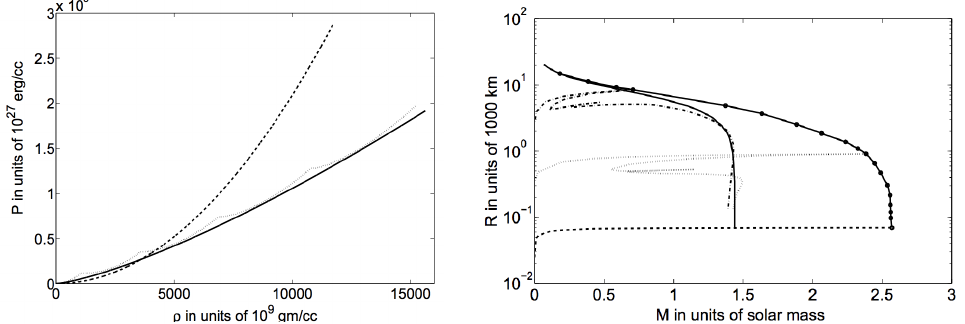
Figure 6. Left panel: EoS for different cases: solid line represents Chandrasekhar’s EoS, and the dotted and dashed lines represent the 5-level (corresponding to very strong B ) and 1-level (corresponding to ultimate EoS for extreme B ) systems of Landau quantization, respectively. Right panel: Mass- radius relations: pure solid line represents Chandrasekhar’s result, and the one marked with filled circles represents the evolutionary track of WD with an increase in B . The dot-dashed, dotted and dashed lines represent WDs with 50124-level, 200-level and 1-level systems of Landau quantization, respectively (corresponding to increasing B ). We set E Fmax = 200 m e c 2 for both panels. See